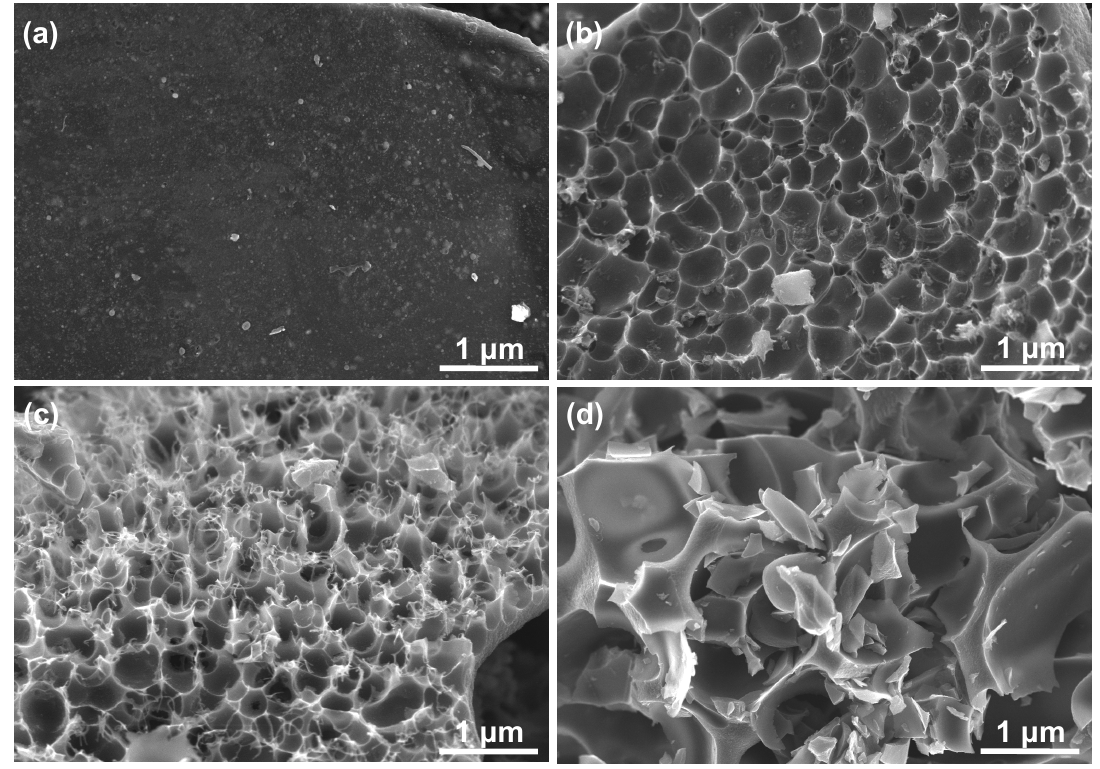
Figure 2. FESEM images of ( a ) HPC-0, ( b ) HPC-1, ( c ) HPC-2 and ( d ) HPC-3, which were synthesized by adjusting the mass ratio of KOH to the intermediate charcoal as 0:1, 1:1, 2:1, and 3:1, respectively.